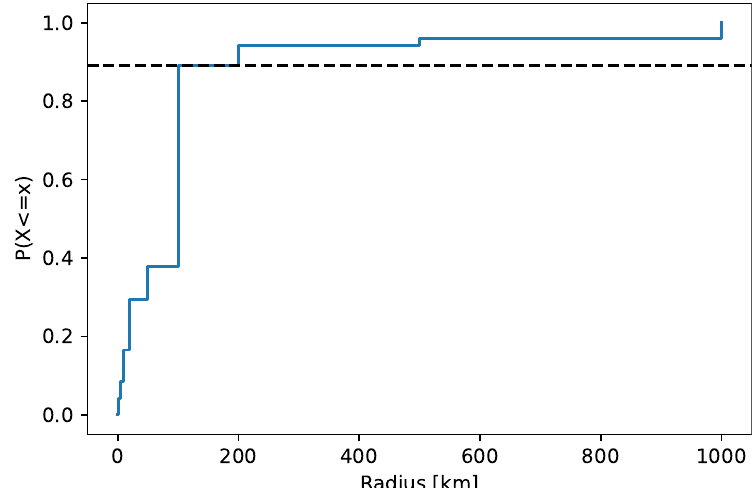
Figure 12. Cumulative distribution function of IP address confidence location area radius in indication events.